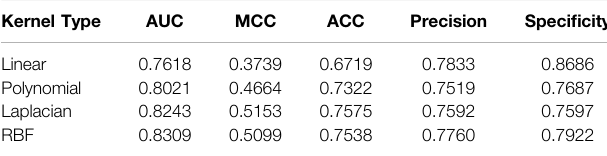
TABLE 3 | Comparison of classi fi cation metrics among different kernels.